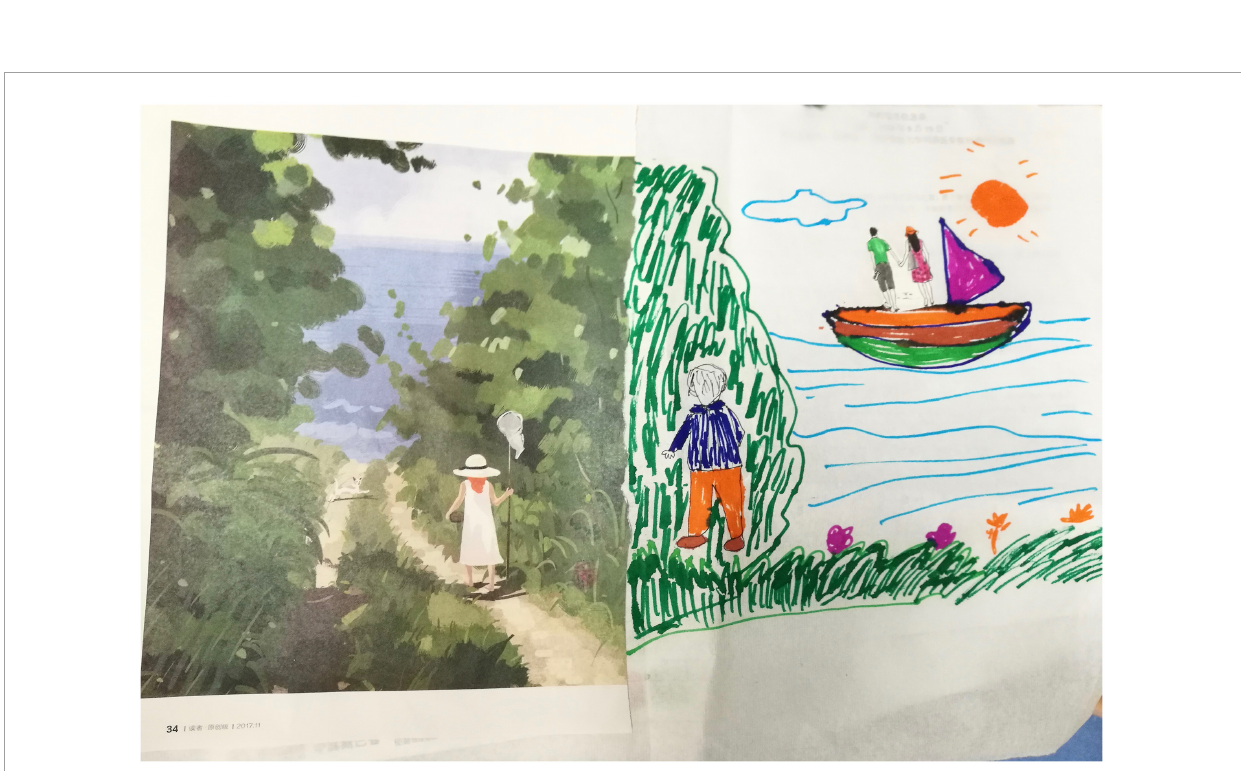
FIGURE2 A painting showing the perception of pregnancy and